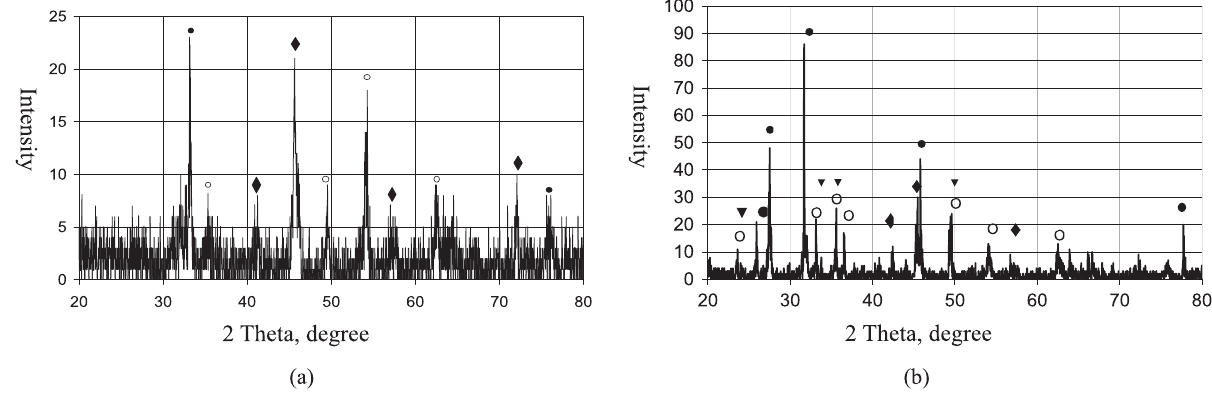
Fig. 3: The XRD pattern of the top layer of the sample (25 mass% FeO – 37.5 mass% CaO – 37.5 mass% SiO 2 ) at temperatures (a) 1773 K and (b) 1673 K. o = Fe